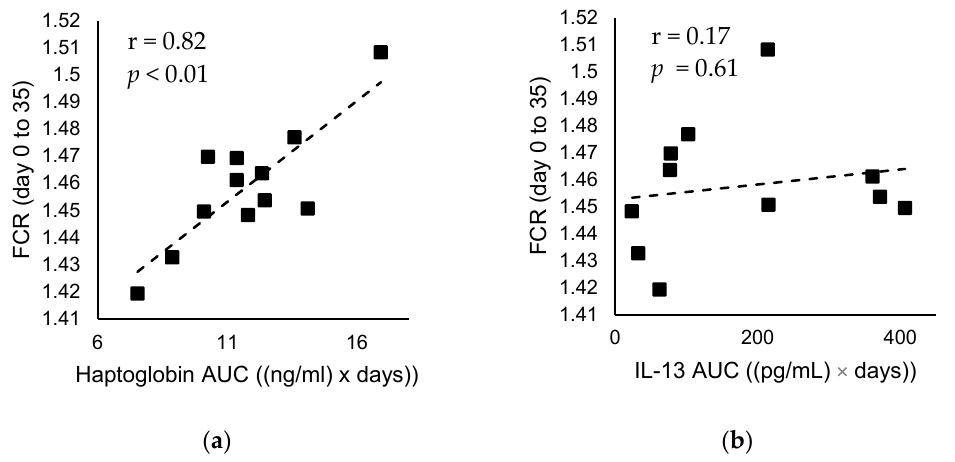
Figure 1. Correlation between measures of immune response and feed conversion ratio (FCR) over the whole experimental period (day 0 to 35). ( a ) Haptoglobin AUC against feed conversion over the whole experimental period, ( b ) Interleukin-13 AUC against feed conversion over the whole experimental period. r, Pearson correlation coefficient; p , p -value.